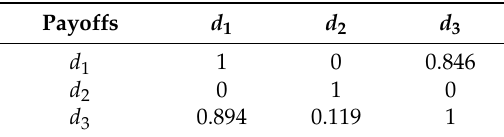
Table 3. Payoff table of r =